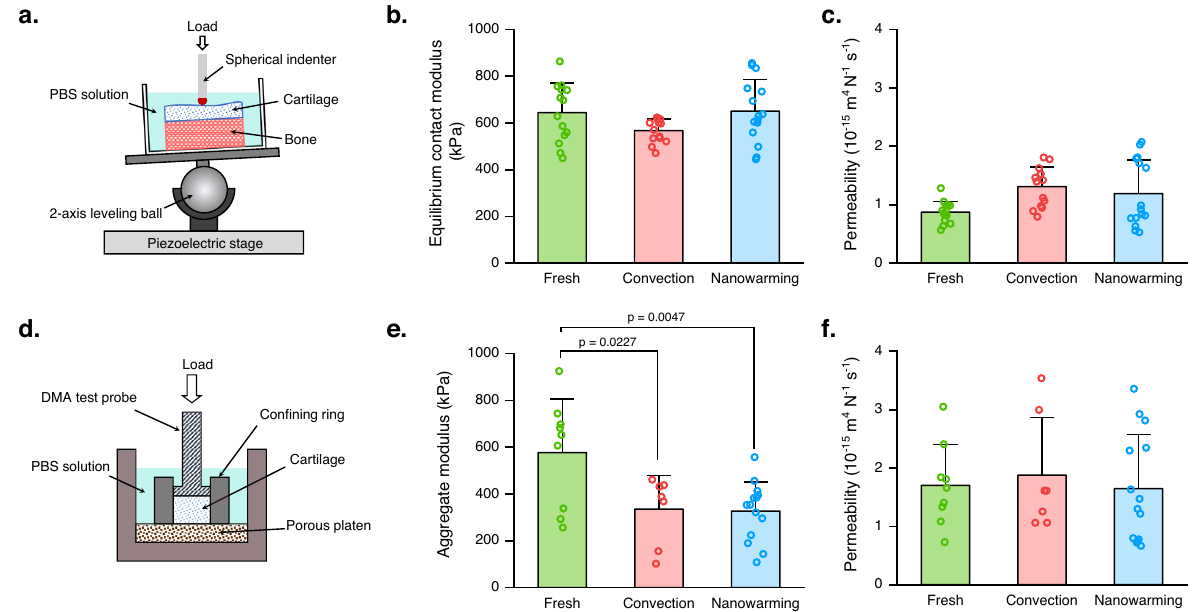
Fig. 4 Depth-dependent changes in cartilage mechanical properties following nanowarming. a Schematic of microindentation experiments. Cartilage surface mechanical properties were measured using a microindentation system consisting of a piezoelectrical stage, a 2-axis leveling ball, a sample chamber, and a spherical ruby ball indenter (1 mm in diameter). Osteochondral plugs were tested while immersed in PBS solutions. b Equilibrium contact modulus results of fresh ( n = 14 measurements from 5 independent samples), convection ( n = 14 measurements from 5 independent samples), and nanowarming ( n = 15 measurements from 5 independent samples) cartilage determined through microindentation tests. c Permeability results of fresh ( n = 14 measurements from 5 independent samples), convection ( n = 14 measurements from 5 independent samples), and nanowarming ( n = 15 measurements from 5 independent samples) cartilage determined through microindentation tests. d Schematic of a con fi ned compression test. DMA dynamic mechanical analyzer. Cartilage plugs were compressed between a test probe (5 mm in diameter) and a porous platen while sitting in a con fi ning ring. e Aggregate modulus results of fresh ( n = 9 independent samples), convection ( n = 7 independent samples), and nanowarming ( n = 14 independent samples) cartilage measured by con fi ned compression tests. p -value was determined with one-way ANOVA with Bonferroni post-hoc test. f Permeability results of fresh ( n = 9 independent samples), convection ( n = 7 independent samples), and nanowarming ( n = 14 independent samples)